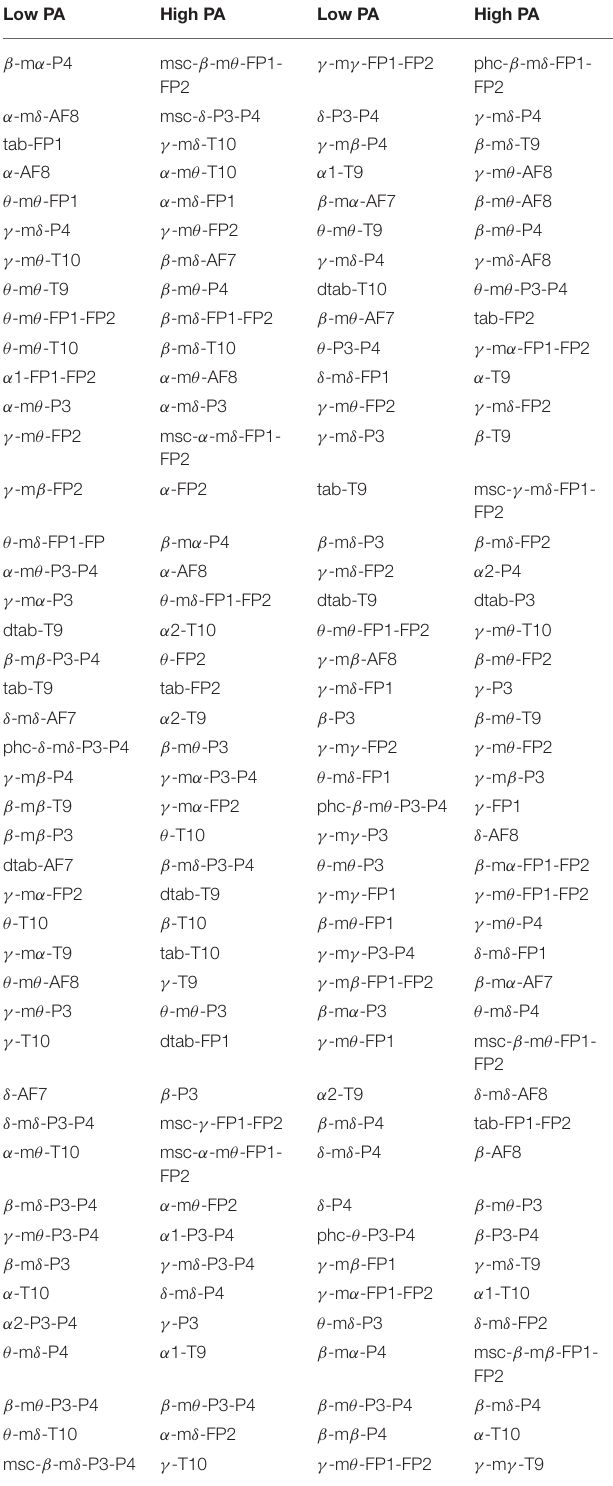
TABLE 3 | Top-60 features for different physical activity (PA) and signal processing conditions.